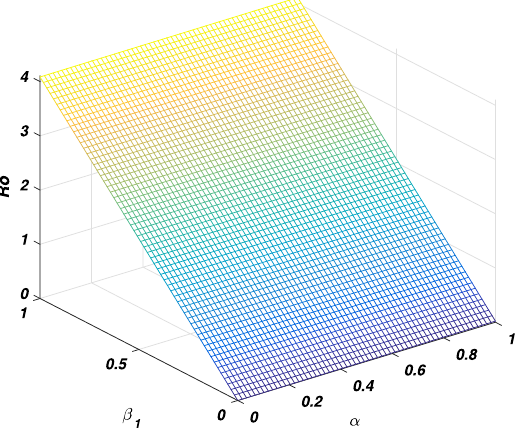
Figure 3. The graph visualizes the variation of the basic reproductive number against β 1 and α .